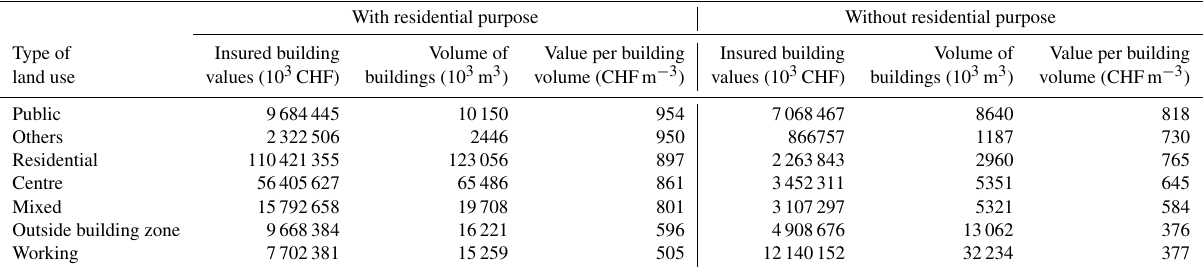
Table 3. Parameter values of model M4, value per volume (CHFm − 3 ) above ground, differentiated according to the area’s land use where each building is located and by the purpose of the building. Calculations are based on insured values of 172562 buildings, which are provided by eleven cantonal insurance companies in Switzerland. Table entries are ordered by the value per building volume of buildings with a residential purpose.